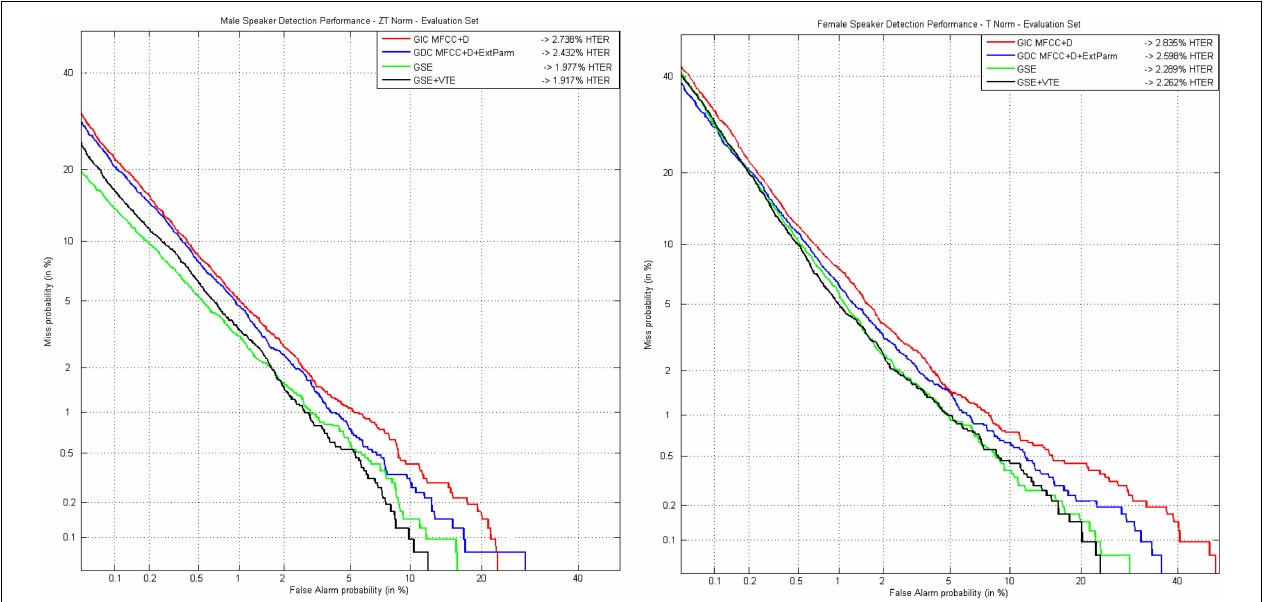
FIGURE 8 | DET curves comparing classical parameters in a gender-independent setup with the GDEB parameterization on ALBAYZIN evaluation set for male (left) and female (right) speakers .